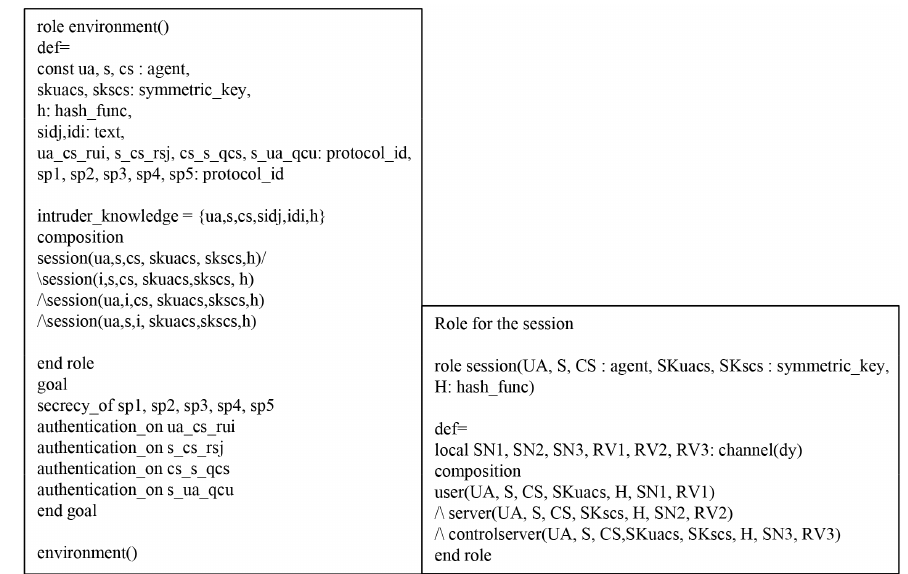
Figure 9. Role for environment and session in